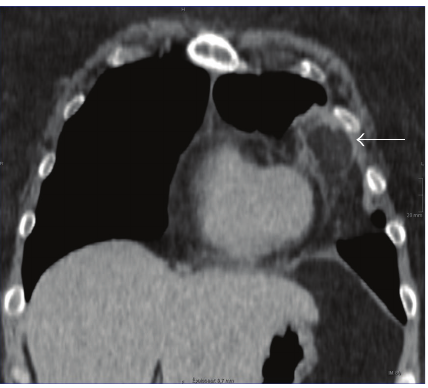
Figure 2: Coronal reformatted CT showing no connection between the pericardial mass and infradiaphragmatic fatty tissues.